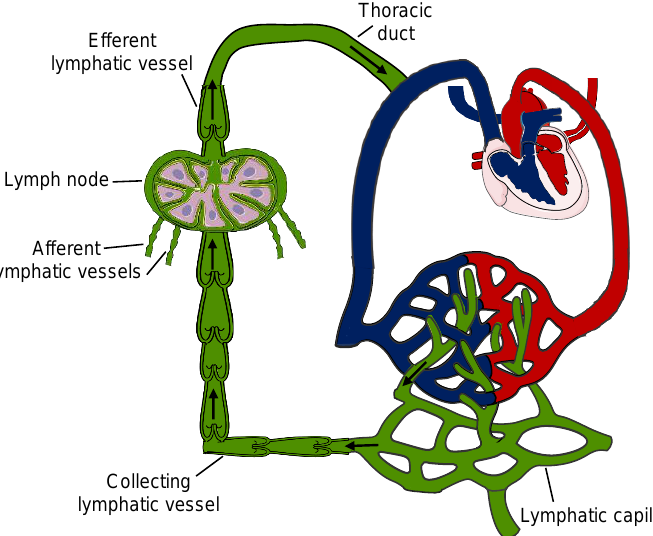
Figure 1. Unidirectional lymph transport. Lymphatic capillaries collect peripheral macromolecules, fluids and cells and then converge into larger collecting vessels containing lymphatic valves, which assures the unidirectional flow of the lymph. These afferent lymphatic vessels subsequently drain to lymph towards the lymph nodes. An efferent lymphatic vessel transports the lymph via the thoracic duct to the subclavian vein into the systemic circulation. Arrows indicate the direction of lymph flow.